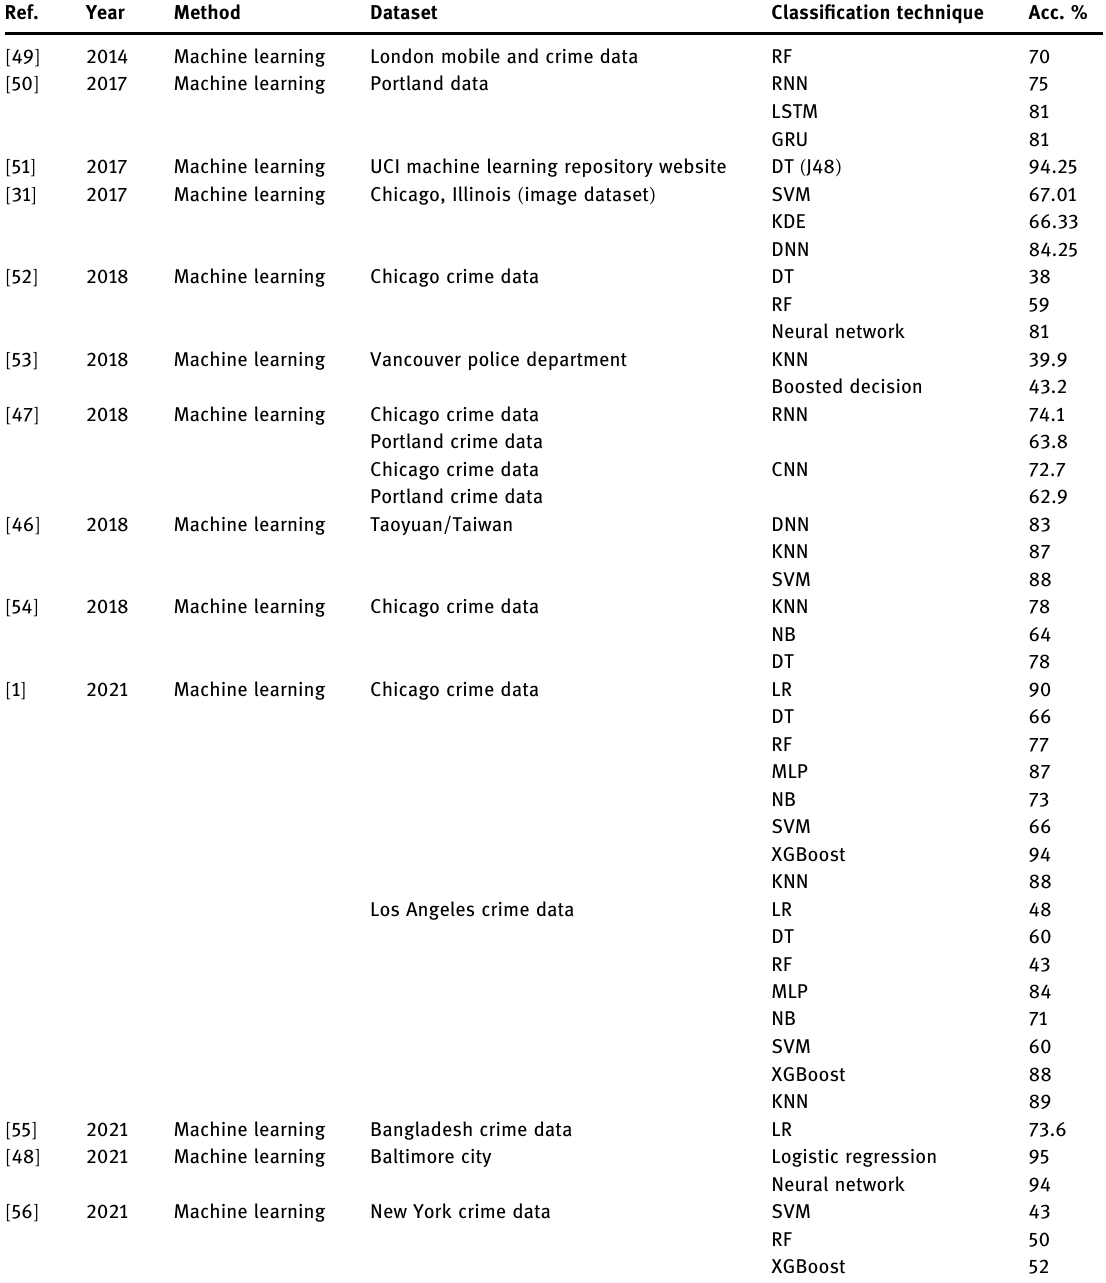
Table 2: Literature survey on crime prediction research works with machine learning